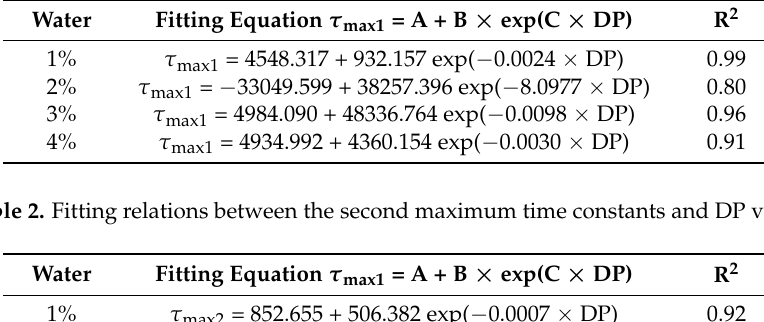
Table 1. Fitting relations between the maximum time constants and DP values.